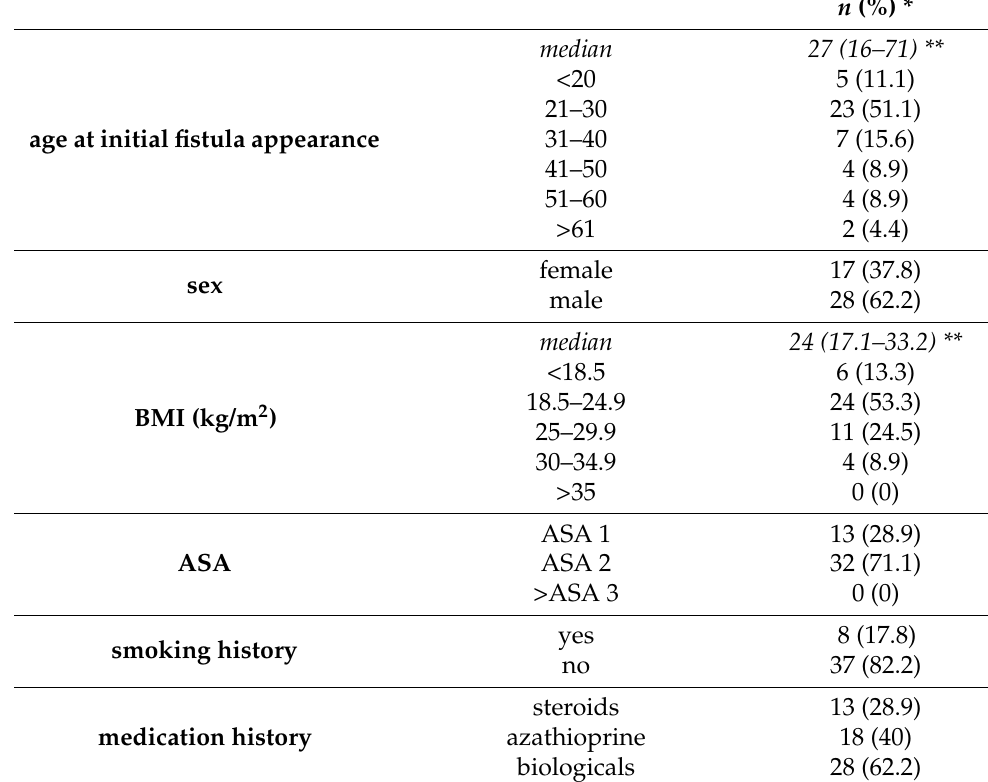
Table 1. Patient